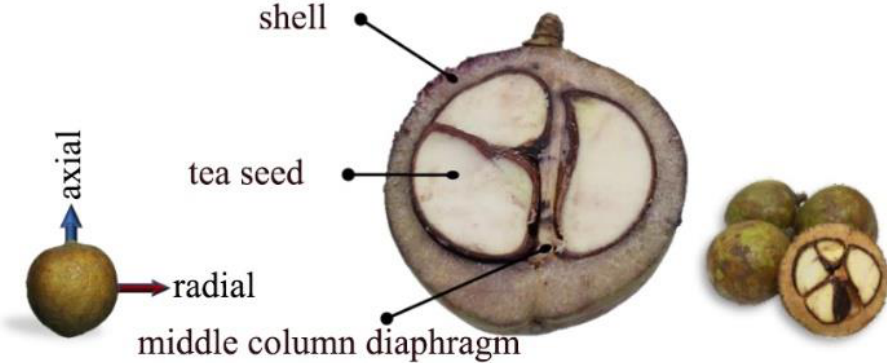
Figure 2. The cross-sectional view of fresh Camellia oleifera fruit.